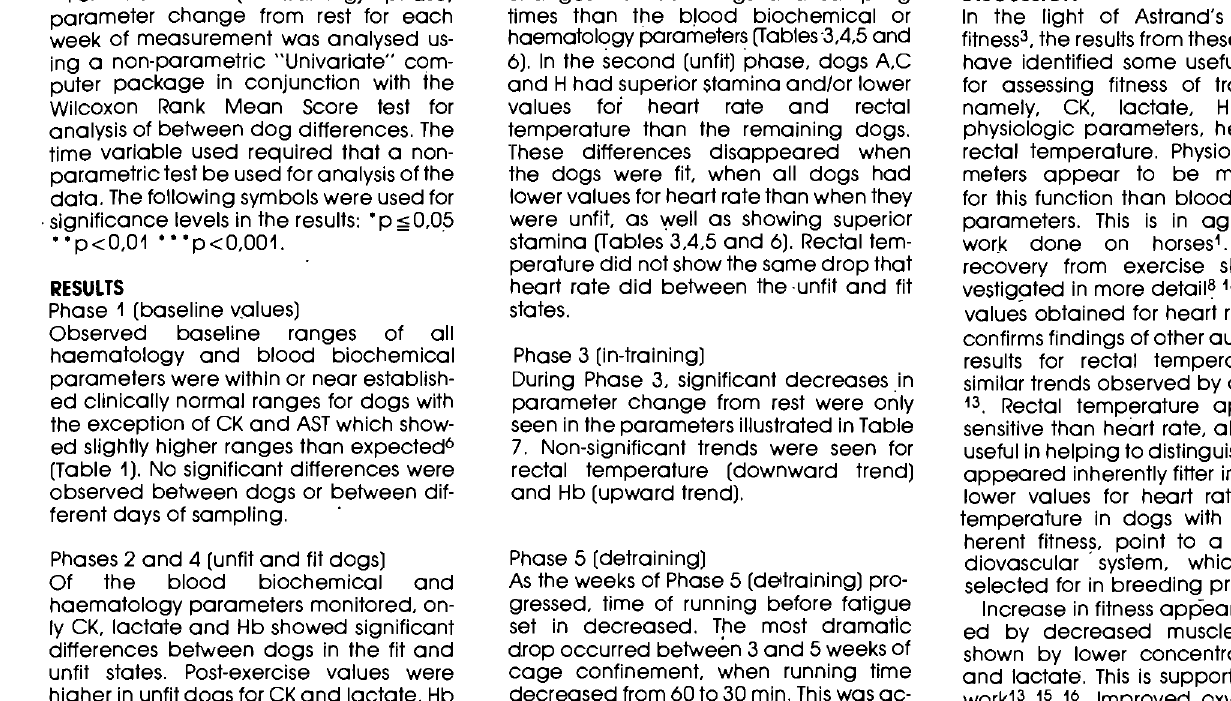
Table 3: Heart rate values for unfit (Phase 2) dogs during exercise. Values are expressed as mean ± sem of 4 treadmill runs per dog